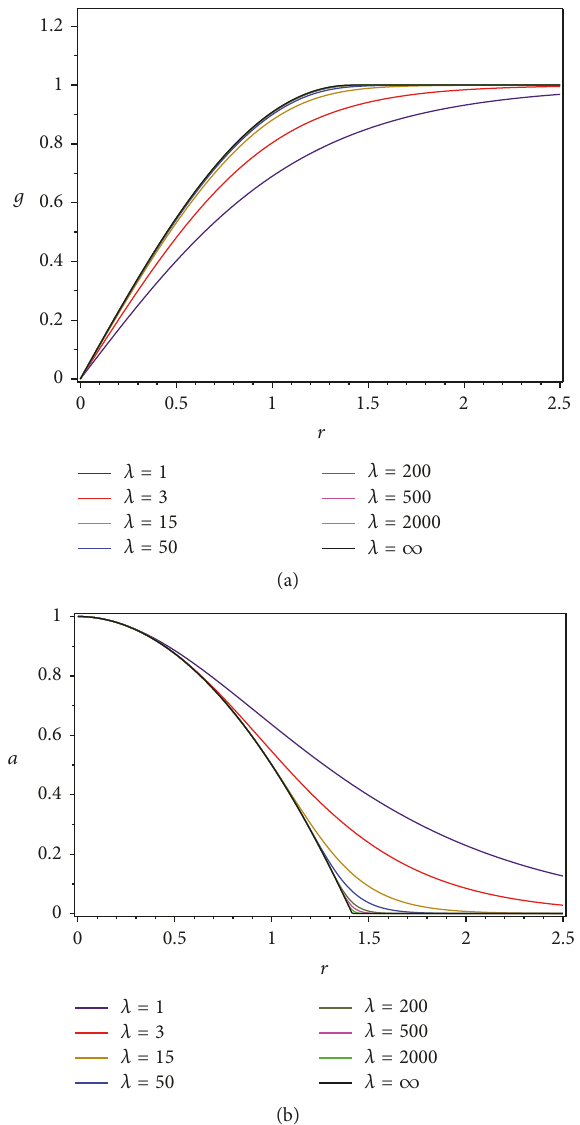
Figure 1: The profiles 𝑔(𝑟) (a) and 𝑎(𝑟) (b) come from generalized Maxwell-Higgs model (1) with 𝐺(𝑔) = 1 and 𝜔(𝑔) = 𝜆𝑔 2𝜆−2 . Observe that 𝜆 = 1 (indigo lines) represents the usual MH model and the true compacton solution is given by 𝜆 = ∞ (black lines).